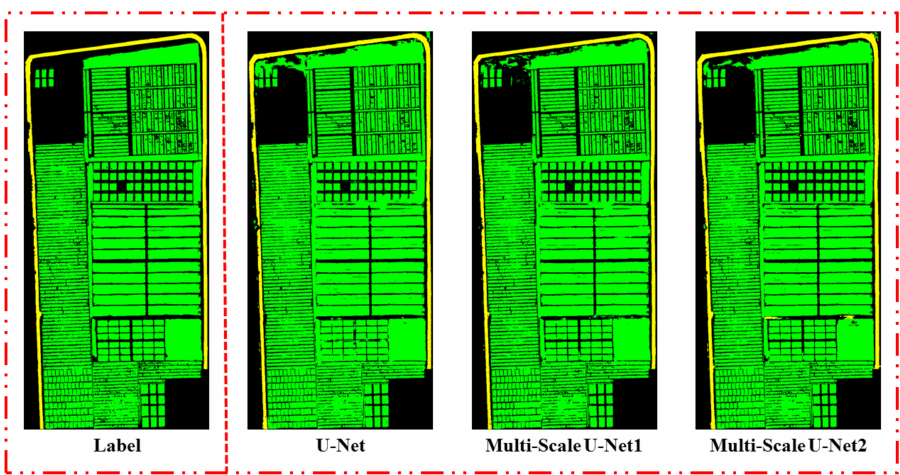
Figure 17. Three network models predict the results (GSD: 3.42 cm × 3.42 cm).